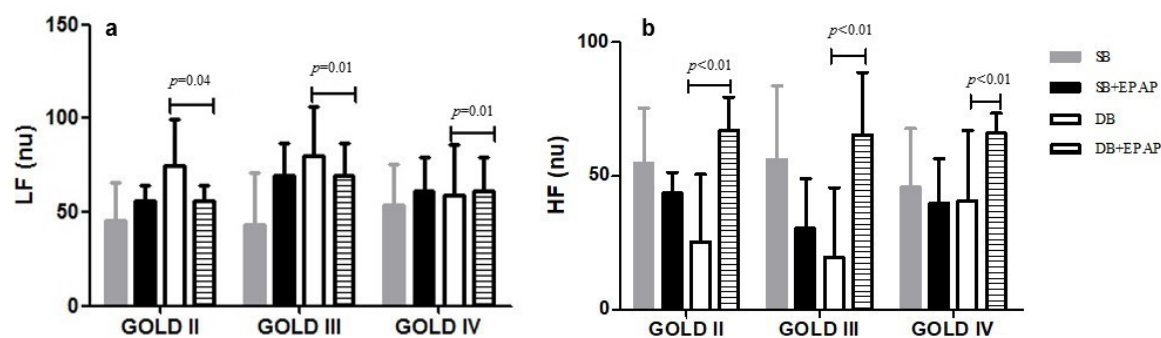
Figure 2. HRV frequency domain parameters stratified according to disease staging. (a) LF- normalized low frequency power; (b) HF- normalized high frequency